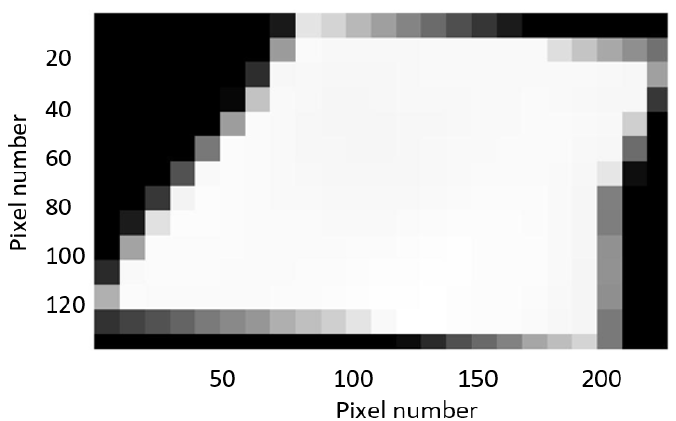
Figure 5. The region of interest of Figure 4 converted to cells of 10 × 10 pixels, and each cell represented by its mean temperature value.